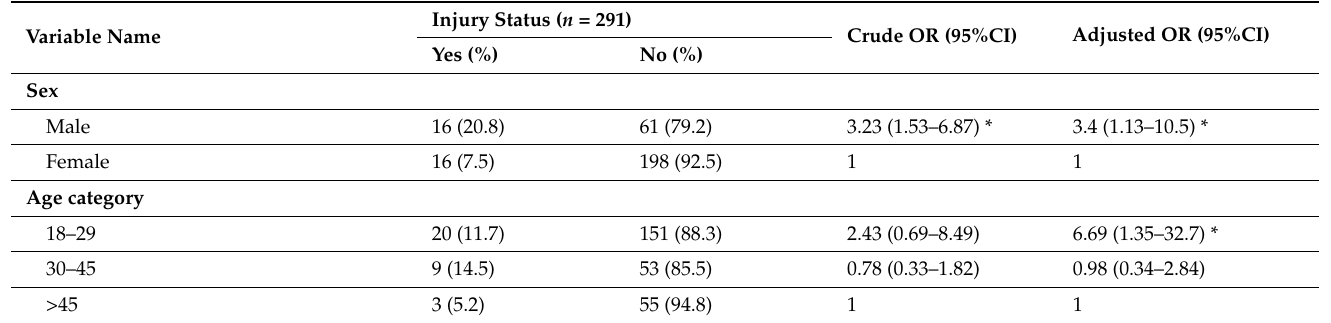
Table 5. Multivariate analysis of individual factors associated with non-fatal occupational injury among integrated textile industry workers, Addis Ababa Ethiopia,